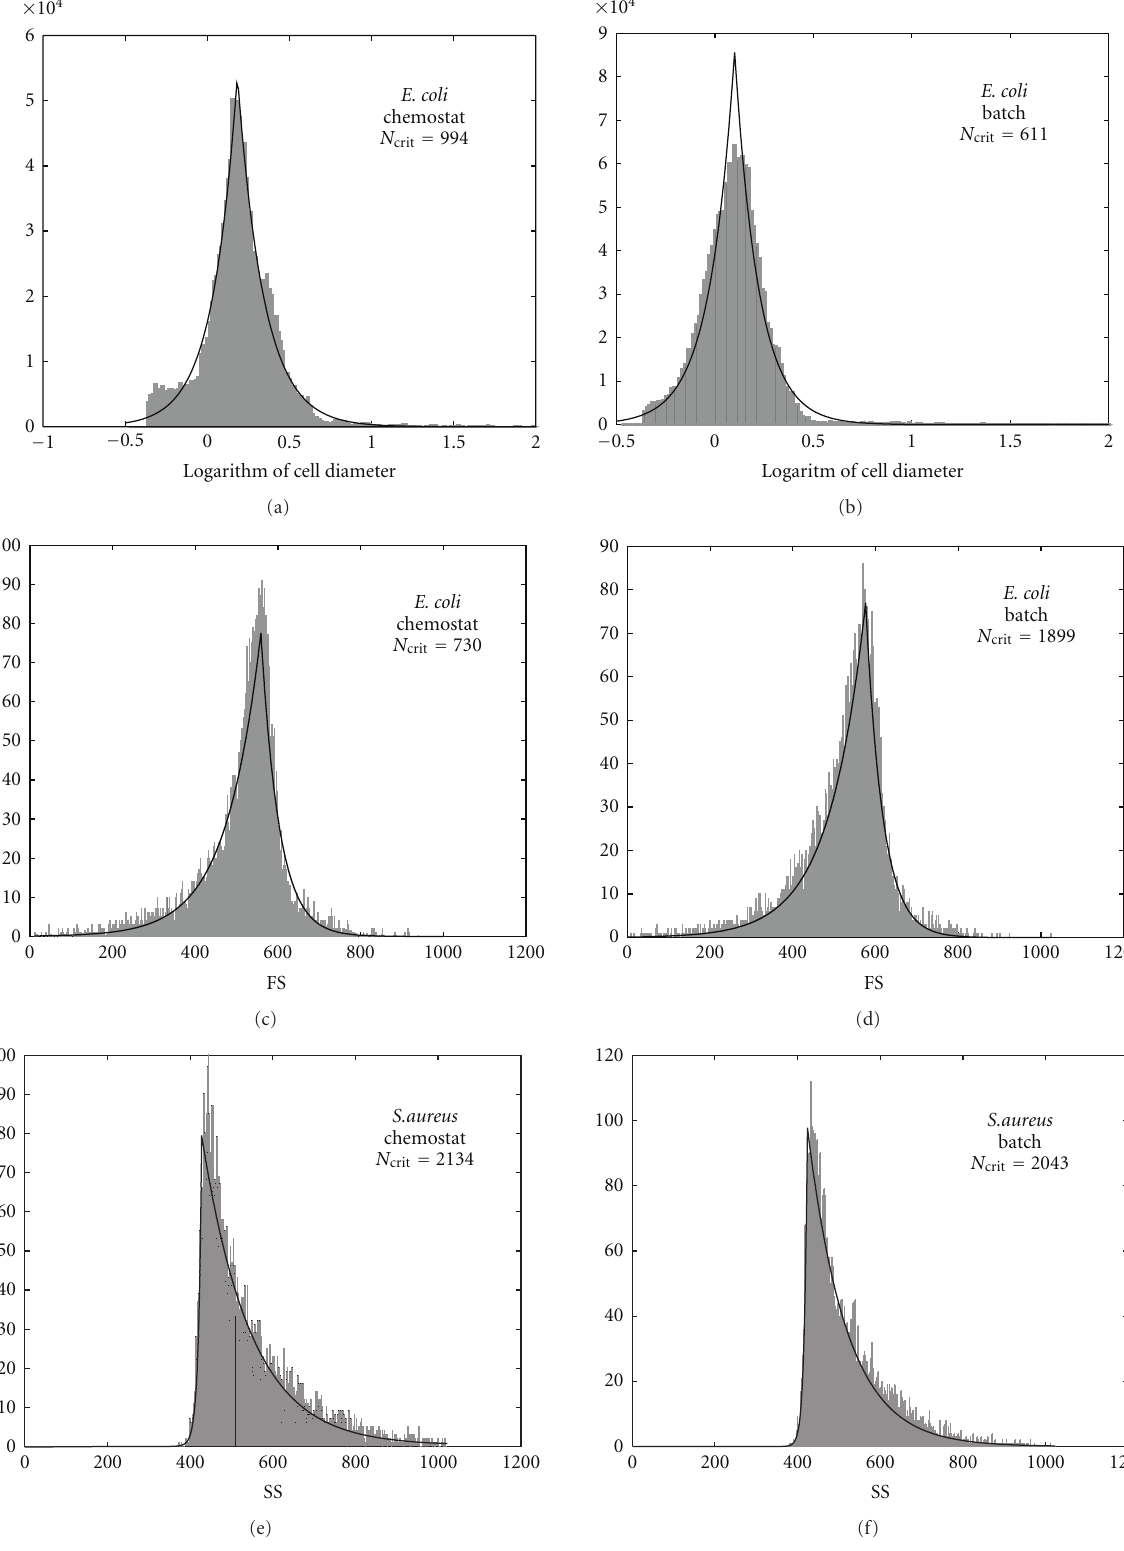
Figure 2: Log-skew-Laplace fit of cell size as well as skew-Laplace fit of cytometric FS and SS values. The data histogram appears in grey shadow and the continuous profile represents the estimated skew-Laplace or log-skew-Laplace fit. E. coli cell size (microns) in chemostat ( D = 1 . 32 h − 1 ) or batch culture (36 h of incubation). E. coli FS in chemostat ( D = 0 . 96 h − 1 ) or batch culture (36 h of incubation). S. aureus SS in chemostat ( D = 0 . 96 h − 1 ) or batch culture (after 20 h of